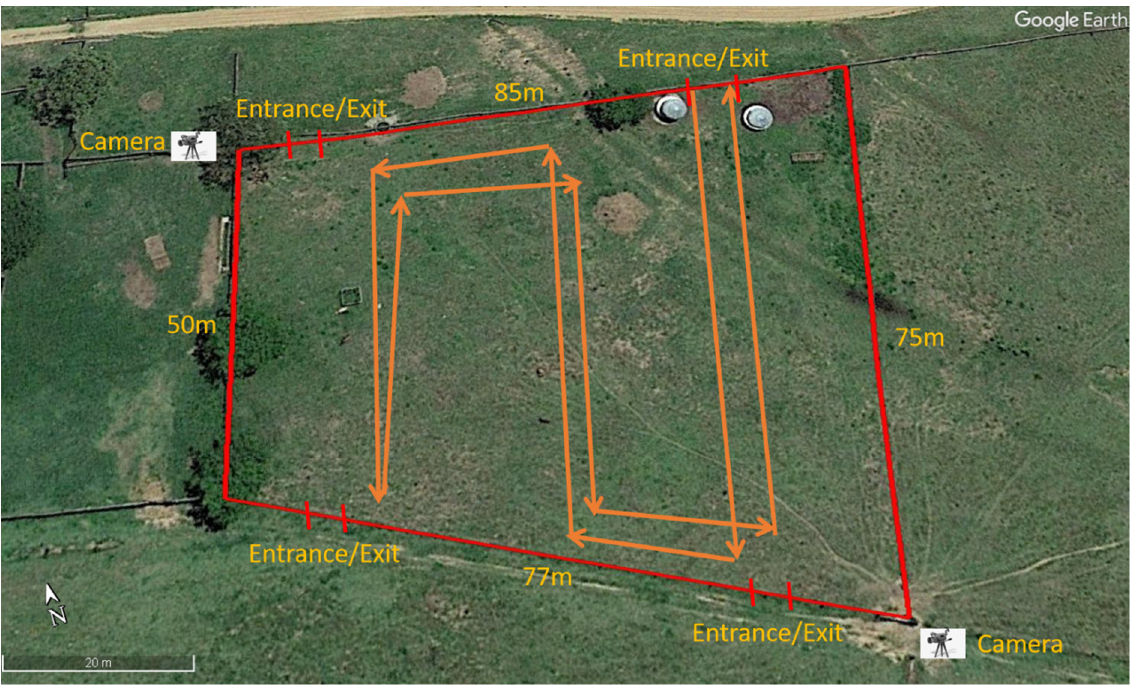
Figure 3. Paddock used for koala – cattle tests (red lines as the boundary) showing an example of the vehicle/model travel route (arrowed orange lines) from one of the four possible entrance/exit points. Map generated with GoogleEarth™.